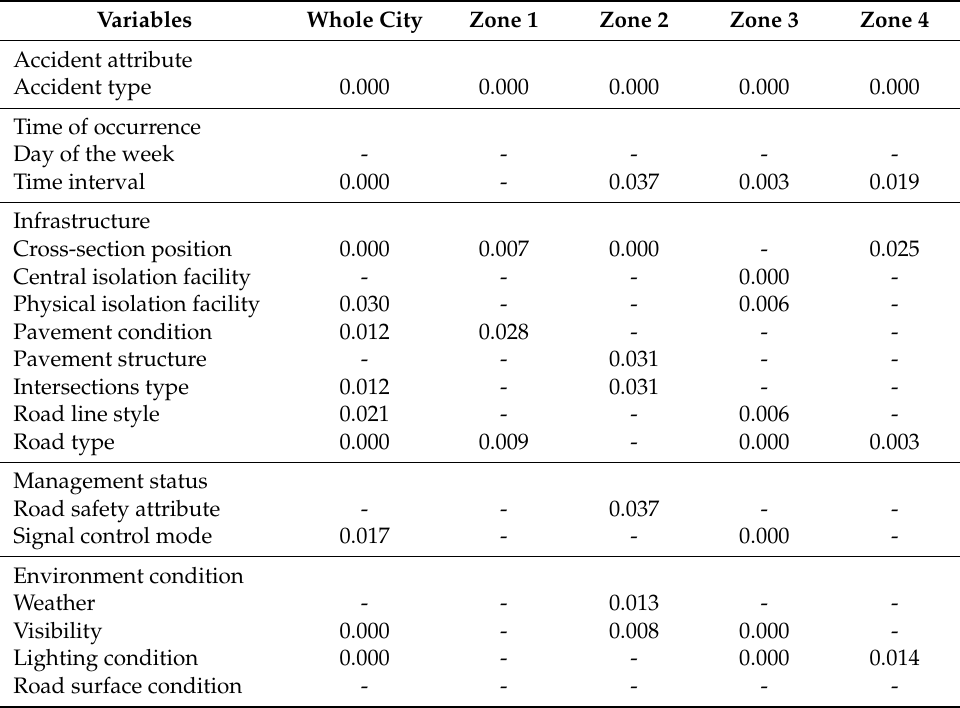
Table 5. Pearson’s chi-squared